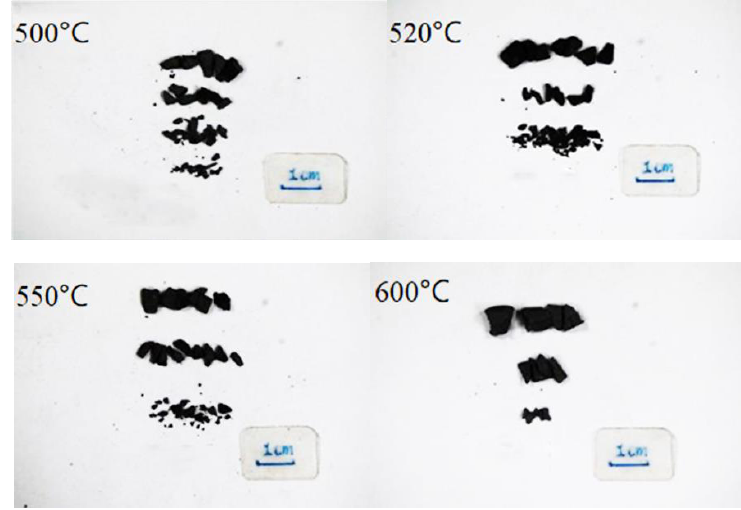
Figure 11. Images of the compression fragments.